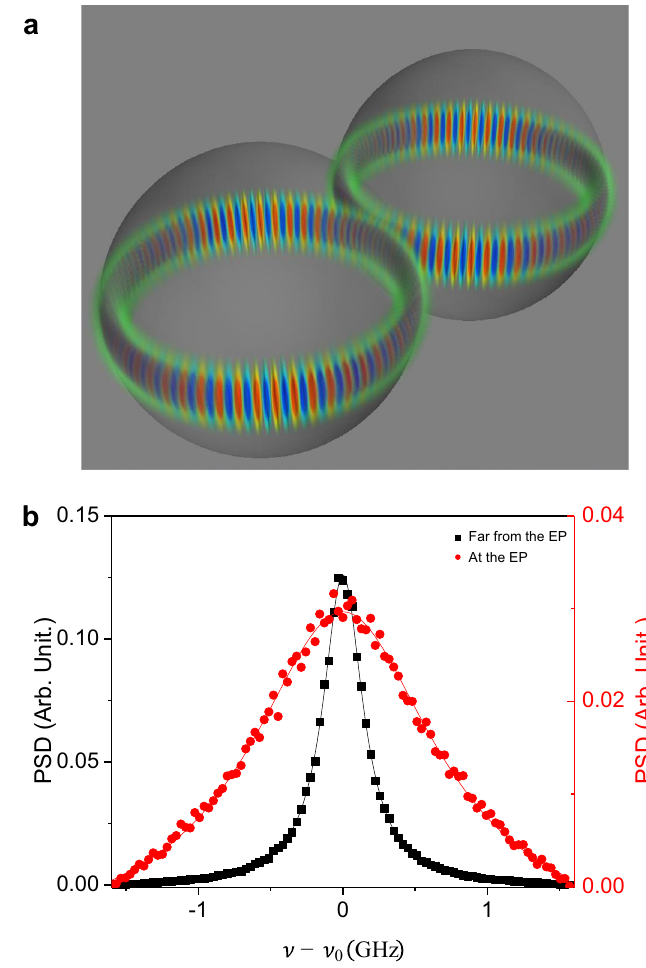
Figure 3. A laser made of coupled droplets as an example and its expected laser linewidth. ( a ) Schematic representation of coupled deformed droplets and two cavity modes forming an EP. ( b ) Red filled circles (black filled squares) represent PSD of the laser at the EP (far from the EP, Lorentzian fits. The standard deviation of the parameter X and the correlation time are assumed as